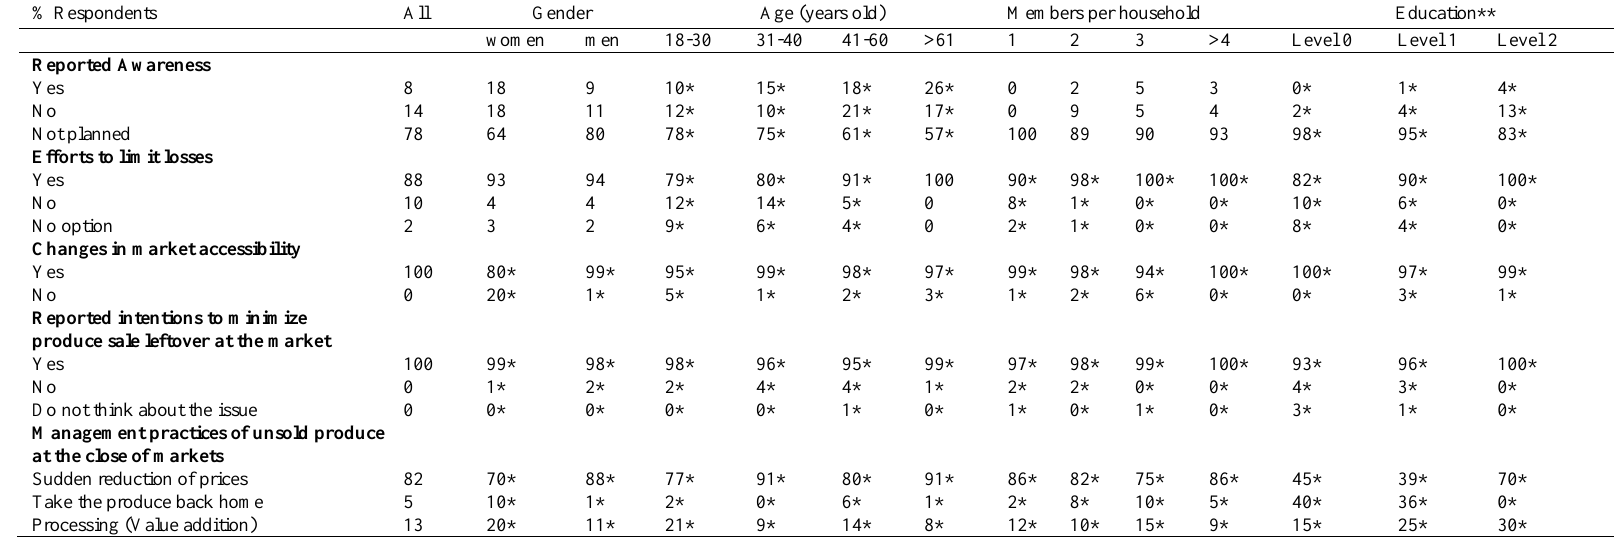
Table 4. The impacts of COVID-19 on horticulture farmers’ awareness, behavior and attitude toward post-harvest losses, results expressed as percentage of the respondents (n=300). %